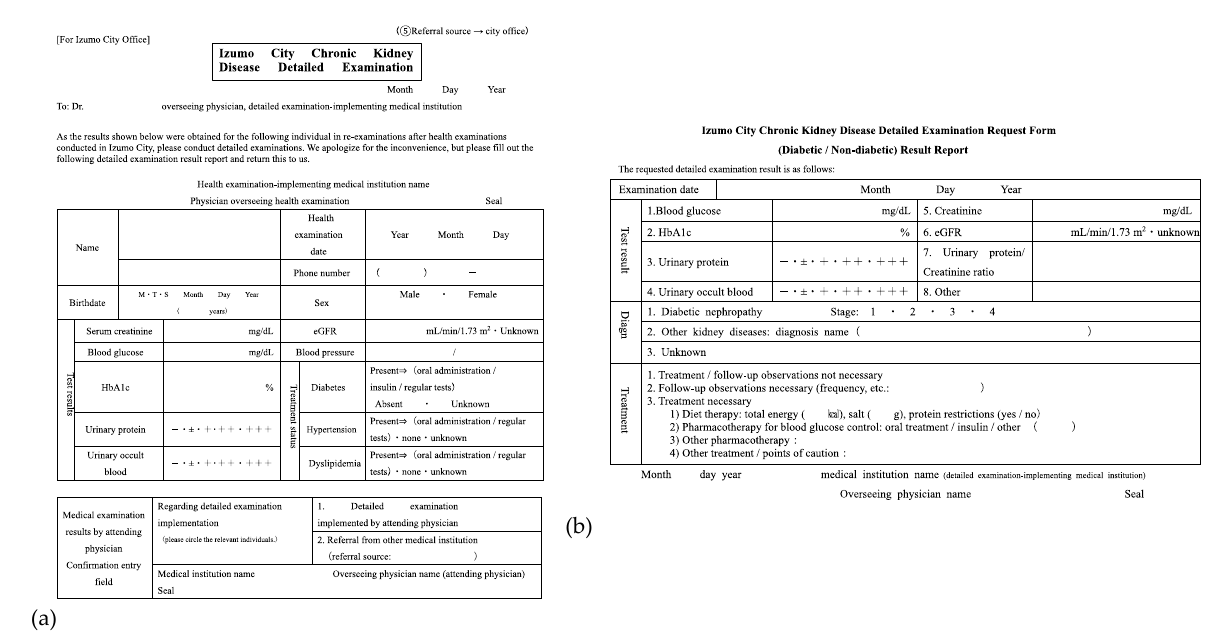
Figure 3. Izumo City Chronic Kidney Disease Detailed Examination Request Form. ( a ) Detailed Examination Request Form; ( b ) Detailed Examination Result Report.